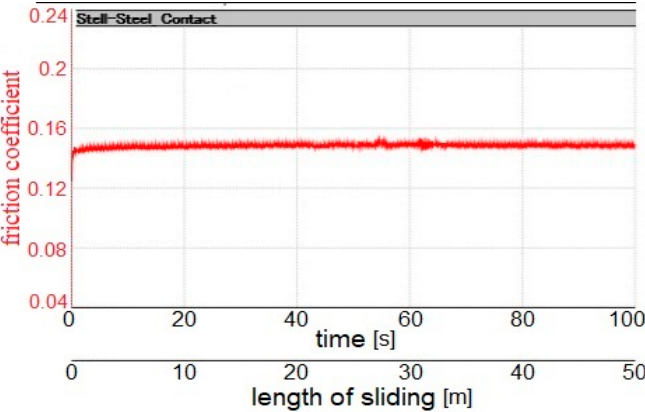
Figure 6. Dependence of the friction coefficient on the length of sliding for the laser-untreated sample surface.